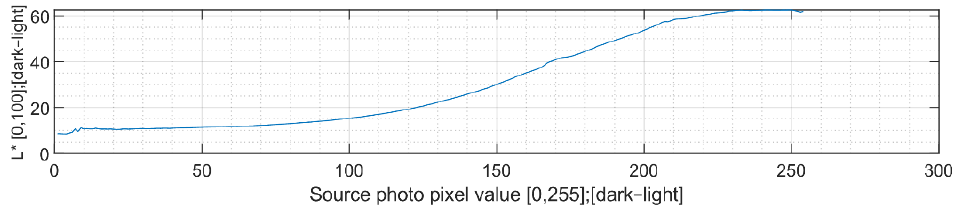
Figure 11. CIELAB L characteristic of wood-engraved picture.